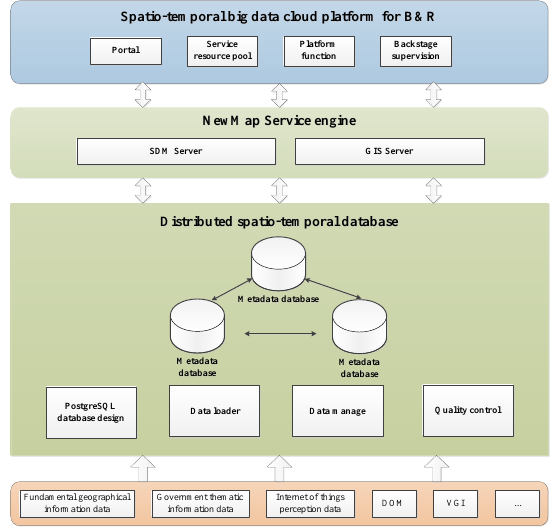
Figure 8. The implementation roadmap of spatio-temporal big data cloud platform of the